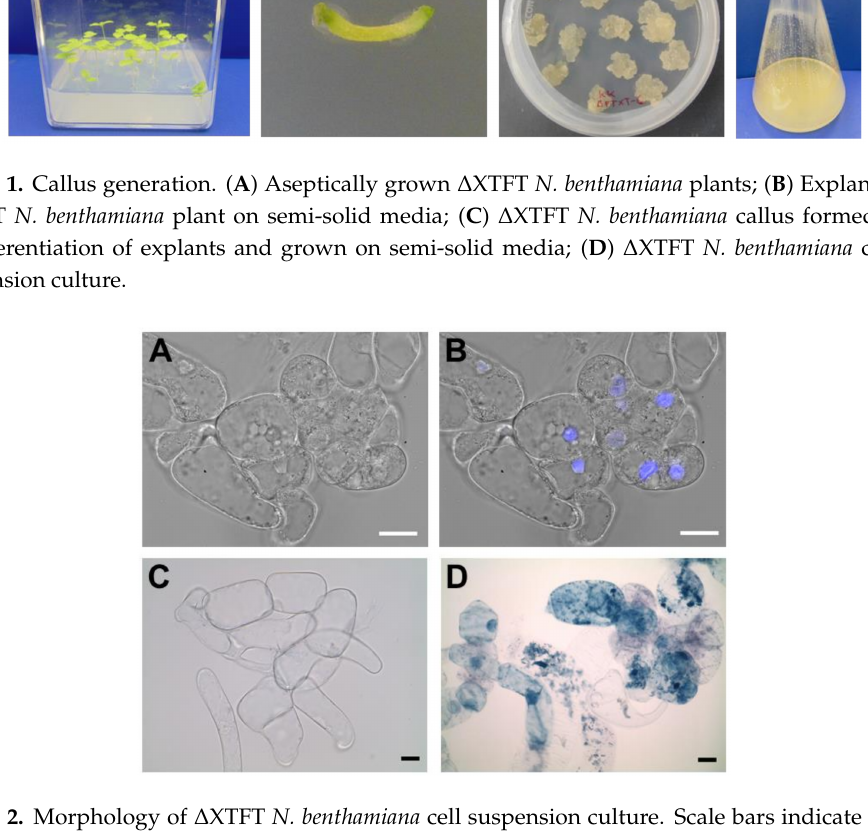
Figure 2. Morphology of ∆ XTFT N. benthamiana cell suspension culture. Scale bars indicate 20 µ m. ( A , B ) Same field of view; ( B ) Nuclear staining with DAPI; ( C ) Cells stained with Evans blue; ( D ) Cells treated with 70% ethanol for 3 h prior to Evans blue